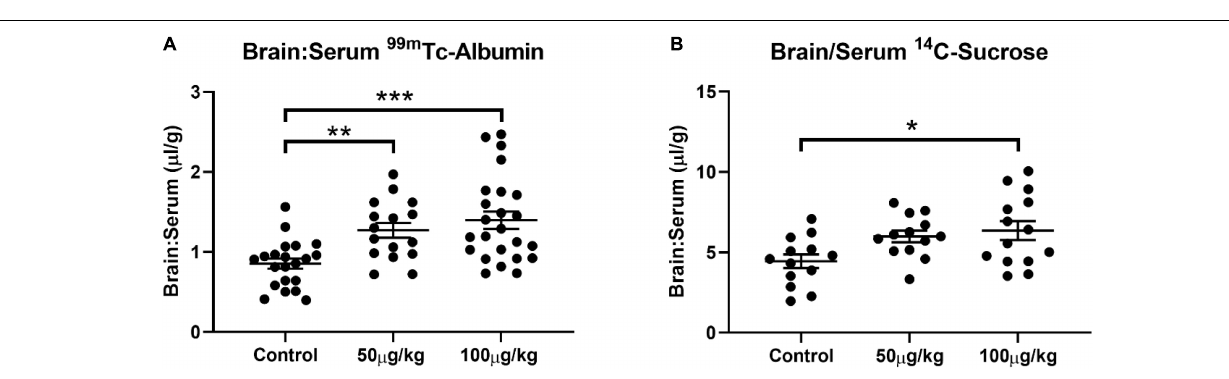
FIGURE 3 | NG291 elicits paracellular and transendothelial transport. Panel (A) displays changes in the brain to serum ratio of 99 m Tc-albumin 15 min after NG291 administration. Likewise, panel (B) is the brain to serum ratio of 14 C-sucrose detected with and without NG291 present in the injectate. (Data is presented